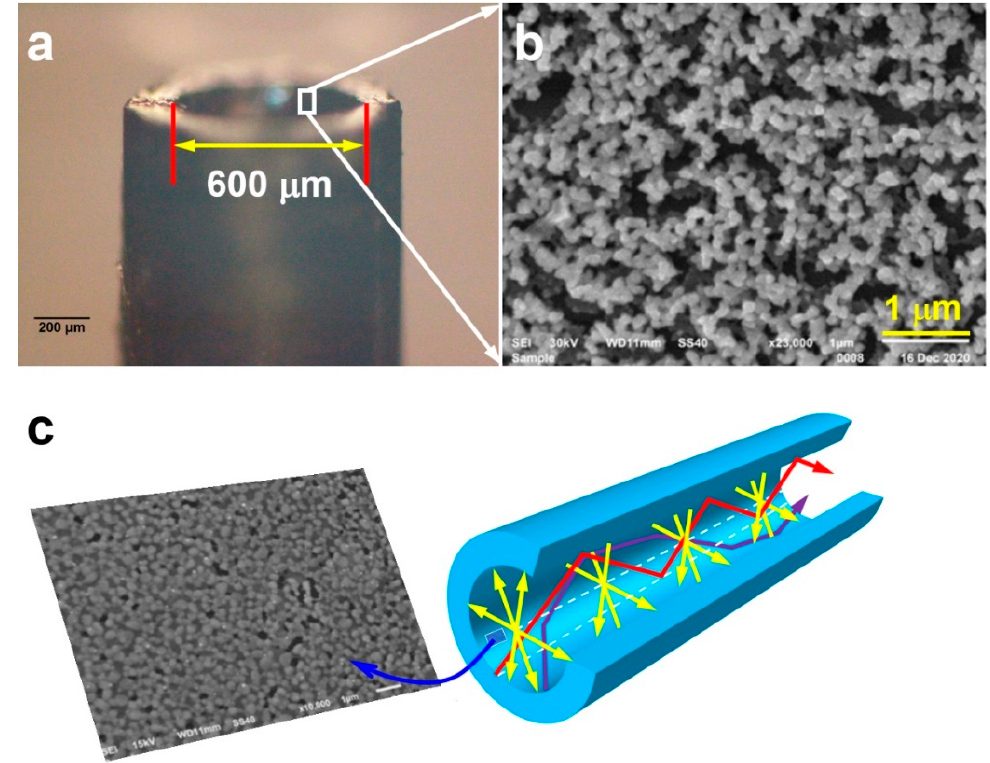
Figure 3. ( a ) Optical microscopic image of the SERS hollow fiber. ( b ) The SEM image of a local area on the inner wall of the SERS hollow fiber. ( c ) Schematic illustration of the principles for the SERS microcavity.